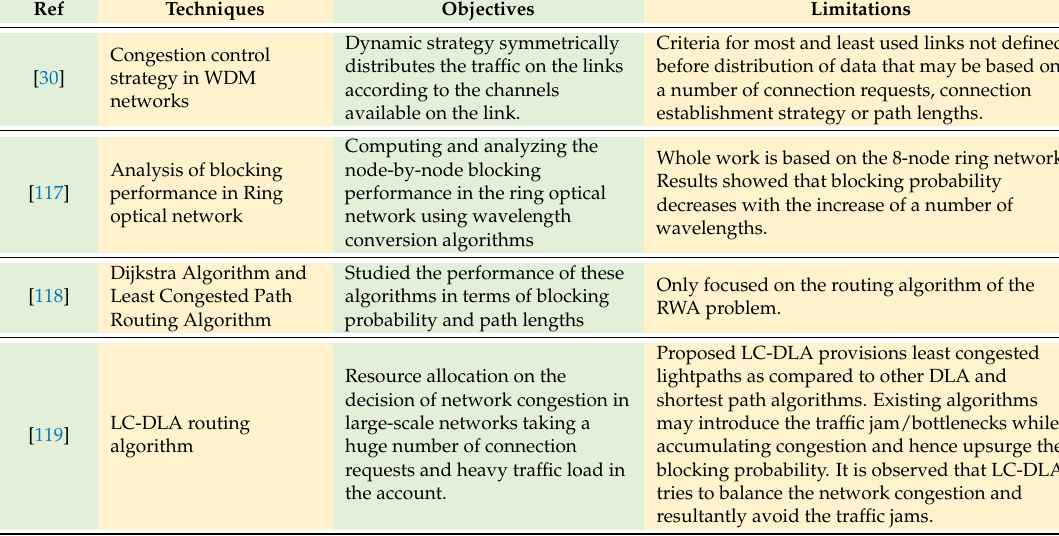
Table 2. Congestion-Aware Routing and Wavelength Assignment